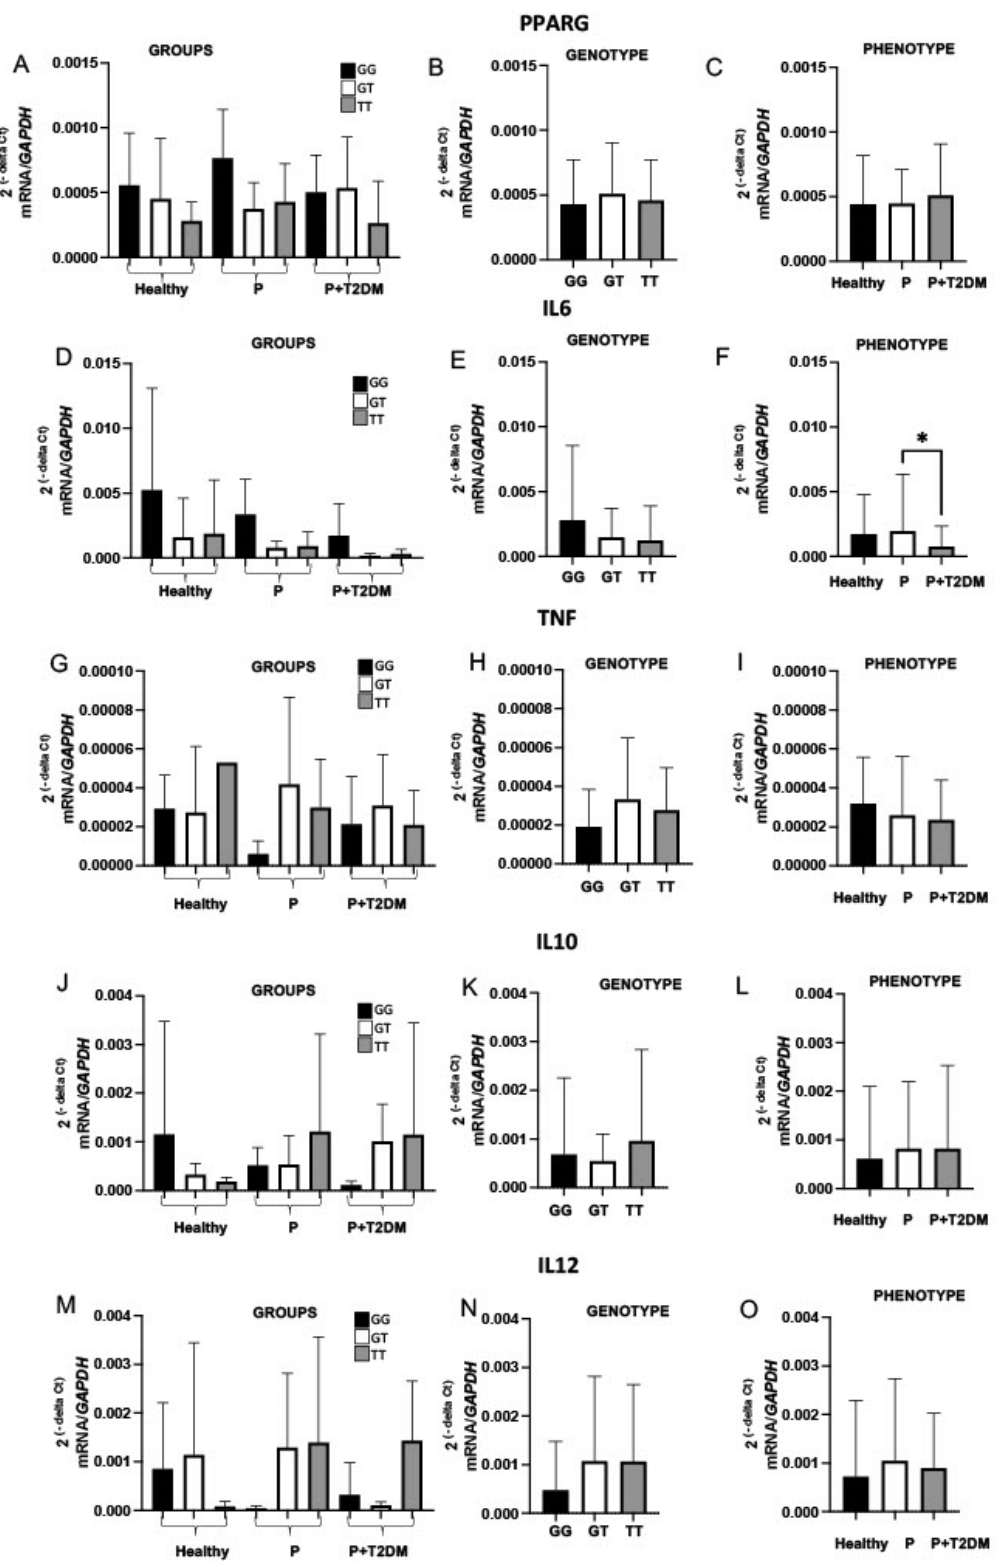
Figure 1. Expression of the PPARG , IL6 , TNF , IL10 , and IL12 genes. The mean and standard error of 2 − ∆ Ct expression values of each gene after normalization by the GAPDH . In the first column ( A,D,G,J,M ), the subjects are divided according to the rs1151999 genotype, namely GG, GT, or TT, and the phenotype (Healthy, periodontitis [P], or periodontitis together with type 2 diabetes mellitus [P +